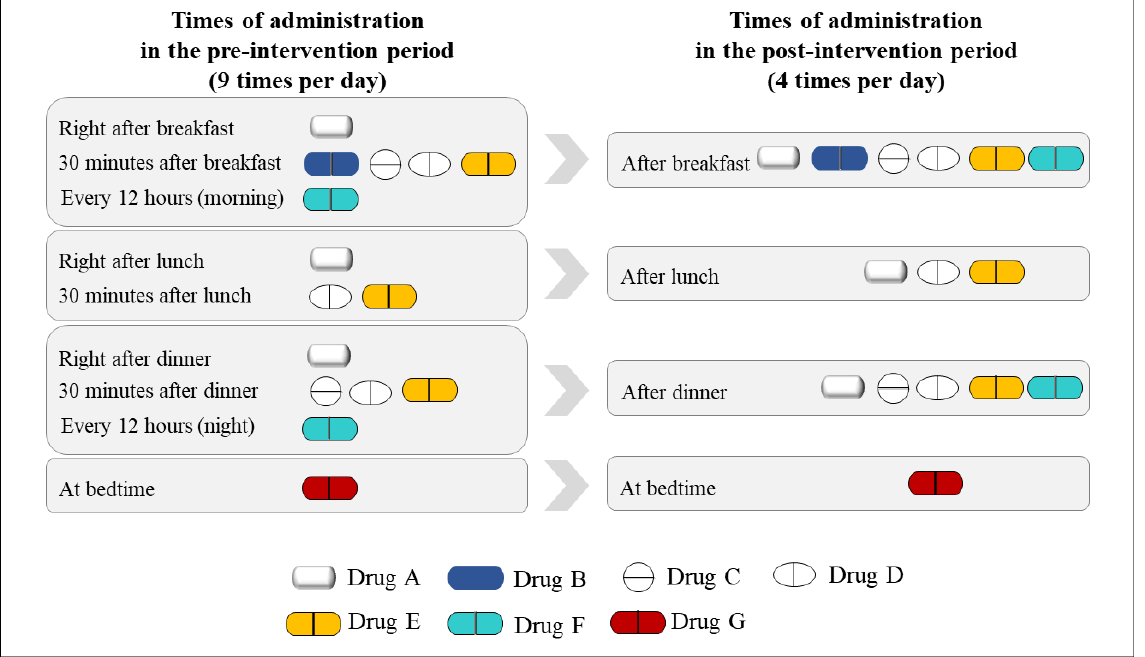
Figure 4. A case example of the improved dosage regimen for a patient.